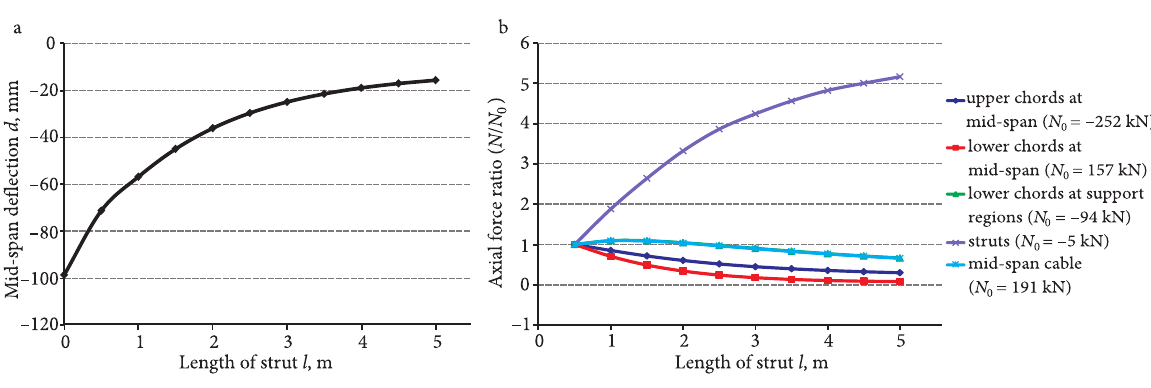
Fig. 6. Variation of mid-span deflection and axial force ratio with the value of K : a – mid-span deflection versus the value of K ; b – axial force ratio versus the value of K Table 1. Comparison of different models